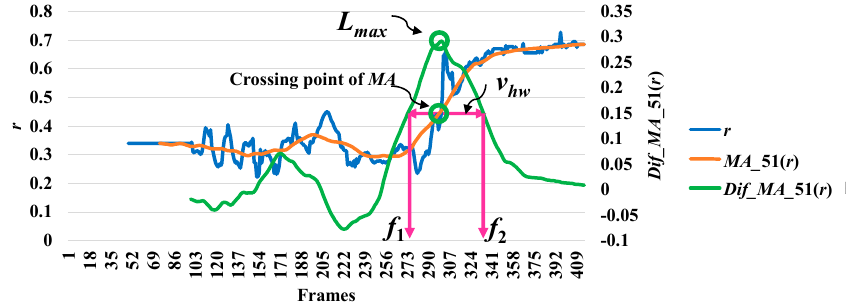
Figure 3. Analysis for a high possibility of abnormal (falling) points based on the aspect ratio ( r ).